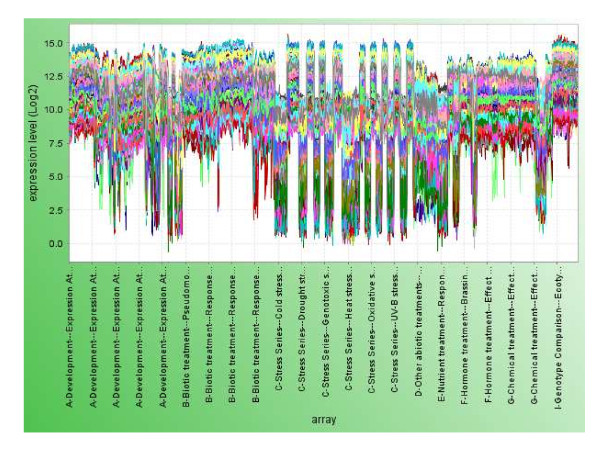
Tight co-expression of the 382 hub genes across all 1094 arrays in AtGenExpree. The figure was generated using MetaOmGraph, a component of the MetNet bioinformatics platform [67].